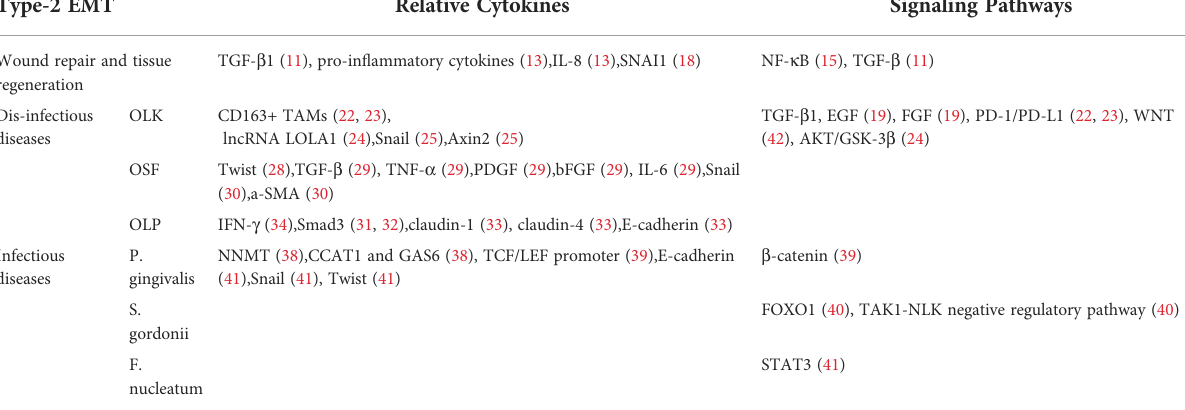
TABLE 1 The mechanisms of Type-2 EMT in biological and pathological processes. Type-2